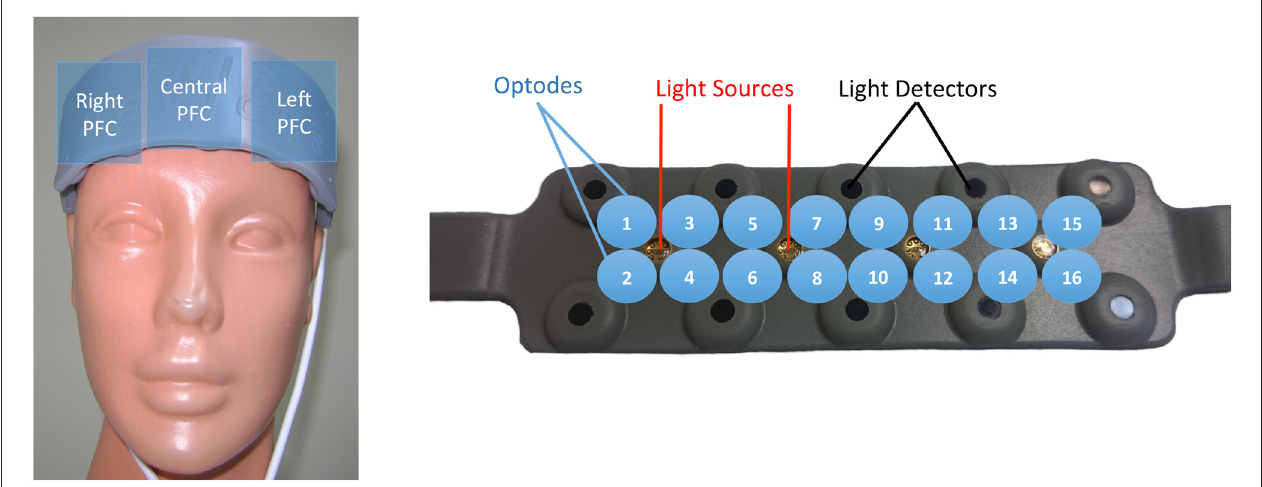
FIGURE 2 | The demonstration of functional near infrared spectroscopy (fNIRS) sensor pad. Brain oxygenation was measured from 16 locations over the forehead area via fNIRS sensor (left side). The sensor pad has 4 light sources, 10 light detectors and 16 optodes (right side). Optodes that are located on the leftmost side of the forehead namely 1, 2, 3 and 4 denotes left prefrontal cortex (PFC), optodes that are centrally located as 7, 8, 9 and 10 denotes central PFC, and optodes that are located on the rightmost side as 13, 14, 15 and 16 denotes right PFC.